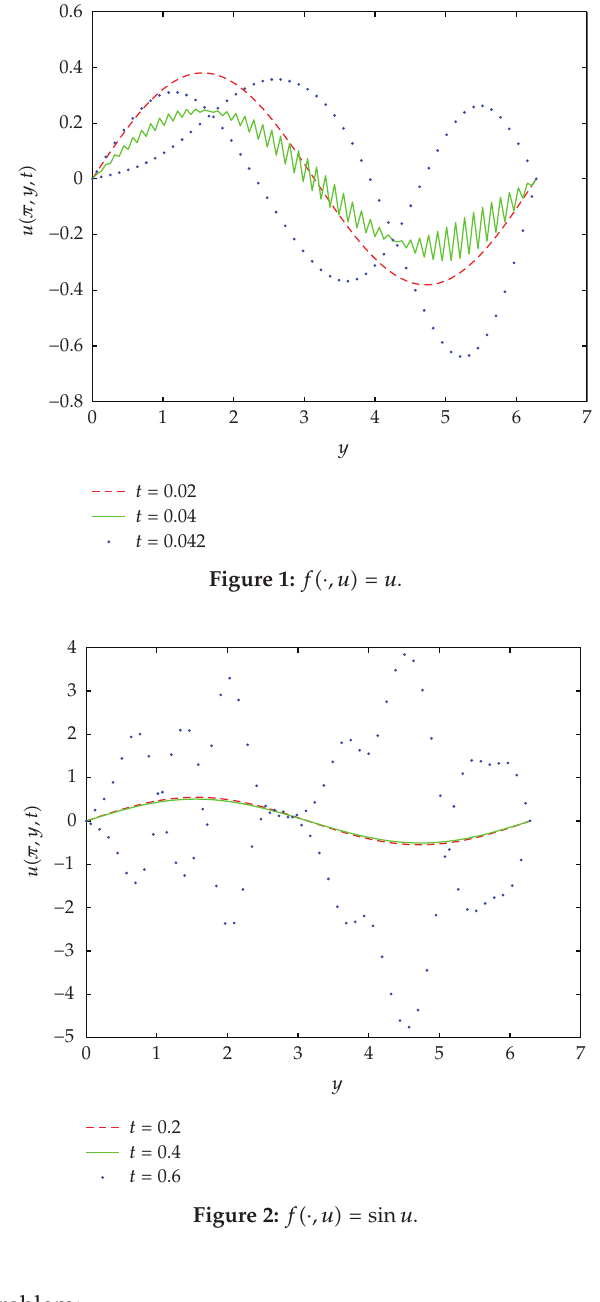
Figure 2: f (cid:6) · ,u (cid:7) (cid:5) sin u